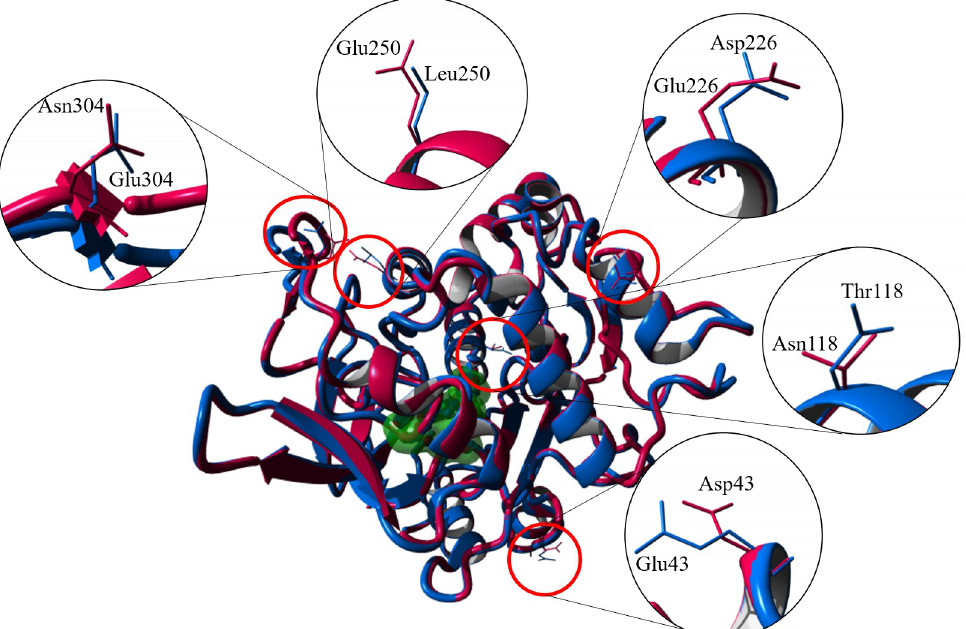
Fig 4. Superimposed of lipase crystal structure 5M mutant lipase (7BUK) and its native structure, T1 lipase (2DSN). The location of the mutations was highlighted in the red circle.